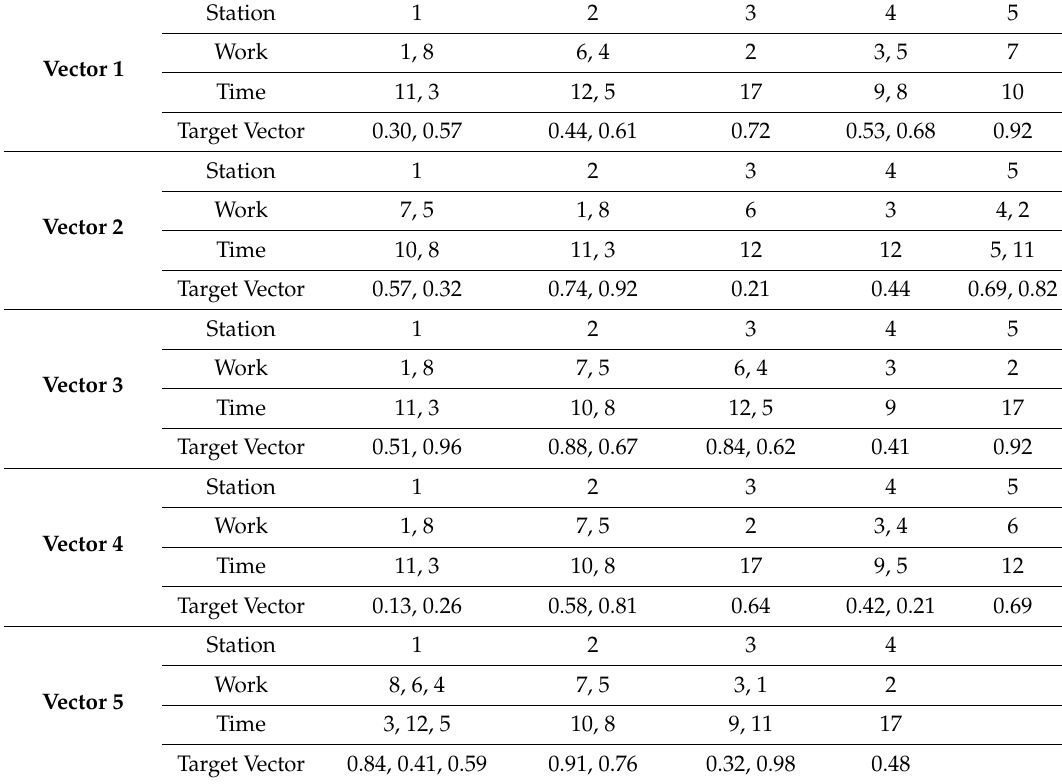
Table 1. Result of initial population NP = 5